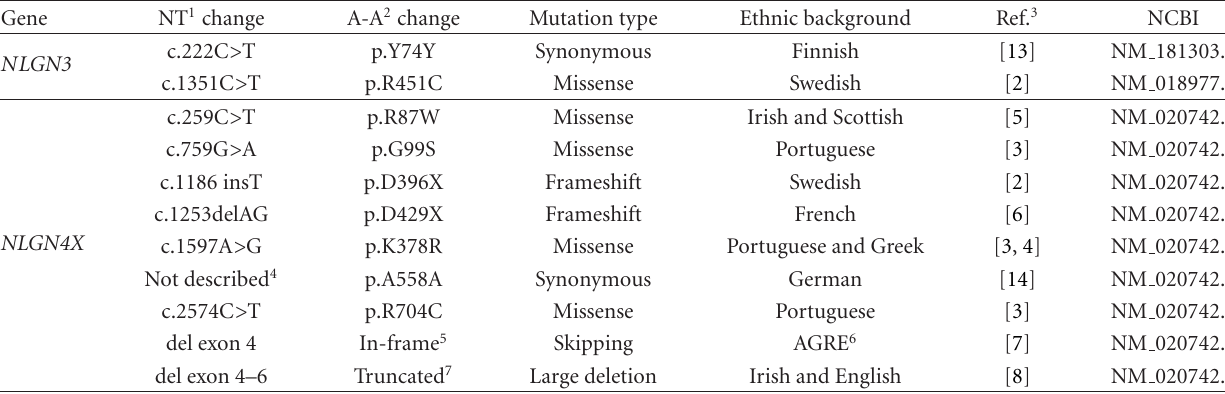
Table 1: Previously identified sequence variations in coding regions in ASD